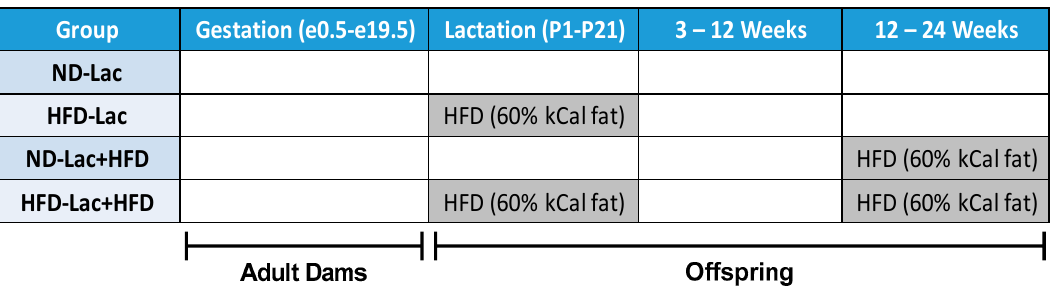
Scheme 1. Experimental